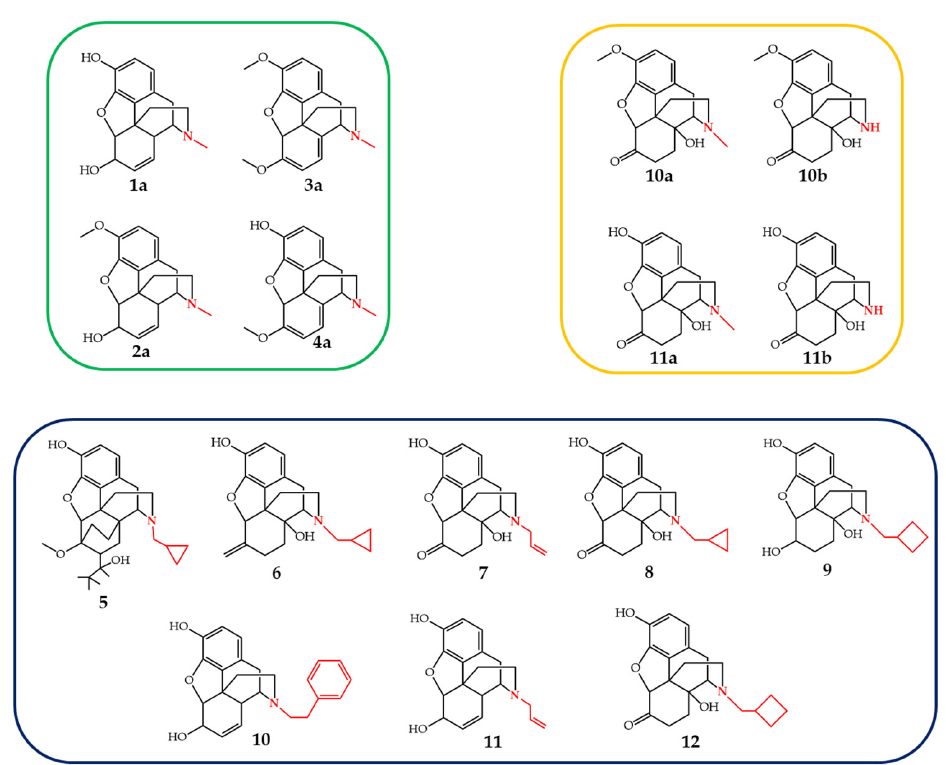
Figure 1. Naturally occurring opiate alkaloids ( green box ), opiate intermediates ( yellow box ), and opiate pharmaceuticals ( blue box ).